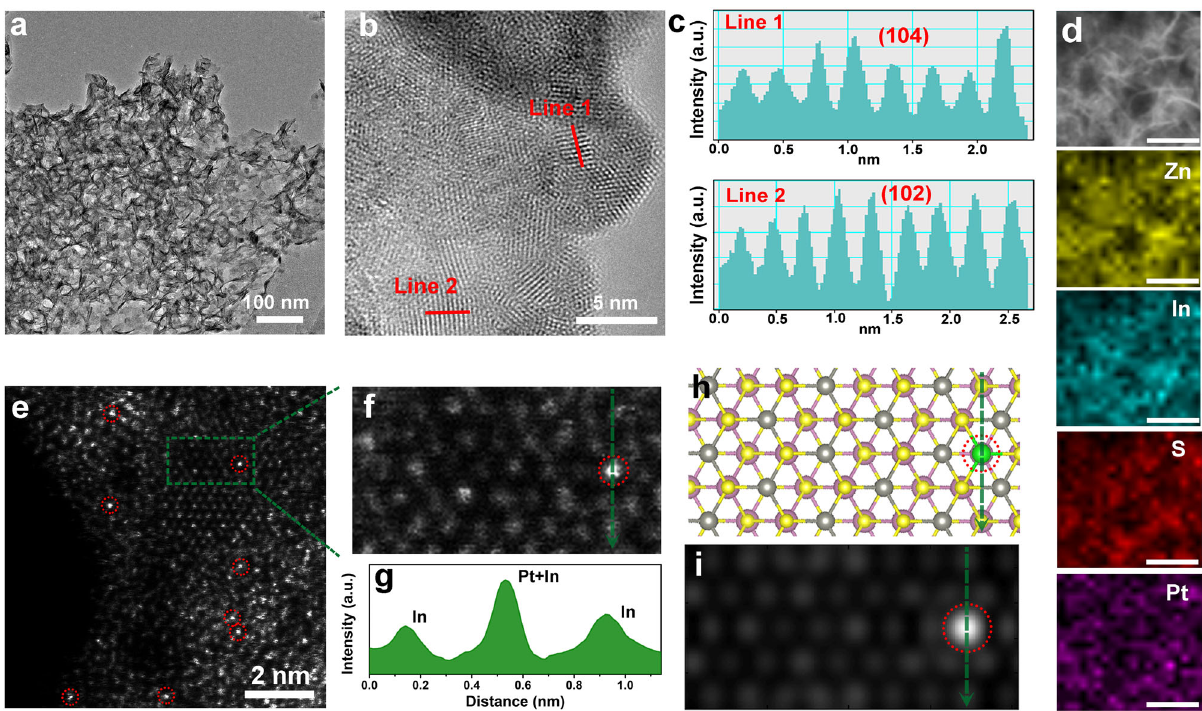
Fig. 1 Structural characterization of Pt 0.3 -ZIS. a TEM image of Pt 0.3 -ZIS. b , c HRTEM image of Pt 0.3 -ZIS. d Elemental mapping of Pt 0.3 -ZIS. The scale bars are 50 nm. e HAADF-STEM image of Pt 0.3 -ZIS. f Magni fi ed HAADF-STEM image of Pt 0.3 -ZIS. g Strength pro fi les from the areas labeled by green line. h Optimized structure of Pt 0.3 -ZIS. The yellow, gray, pink, and green spheres represent the S, Zn, In, and Pt atom, respectively. i Simulated HAADF-STEM image of Pt SS -ZIS according to DFT-optimized